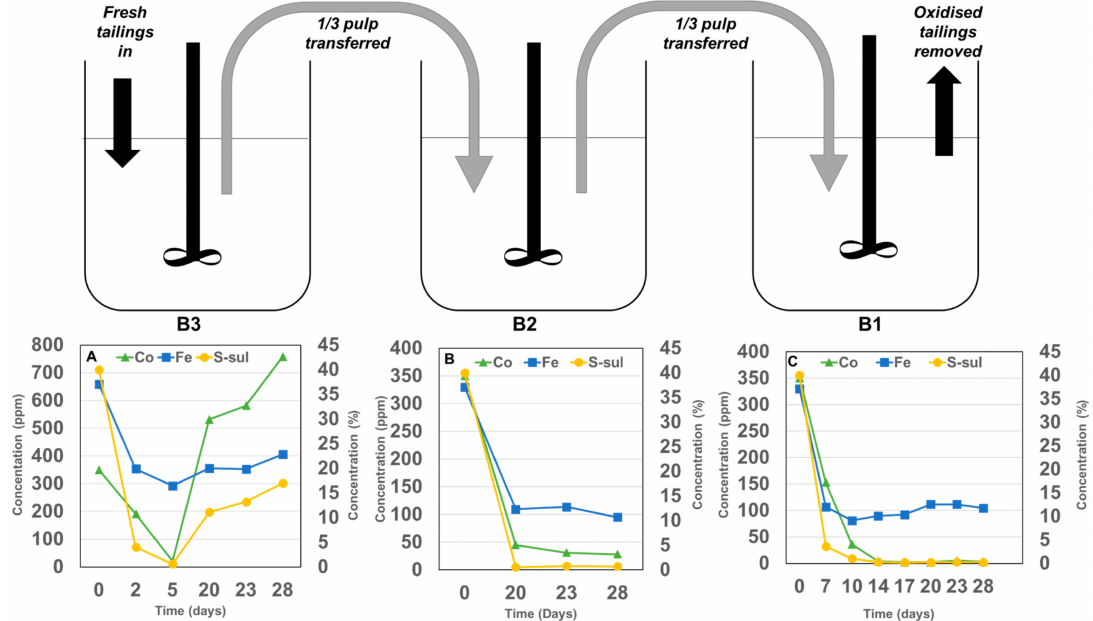
Figure 9. Schematic diagram of continuous tank experiments with transfer pathways, inputs and outputs shown and the concentrations of Fe (%), calculated sulphide-sulphur (%) and cobalt (ppm) in the solids periodically collected from tanks: ( A ) B3; ( B ) B2, and ( C ) B1.